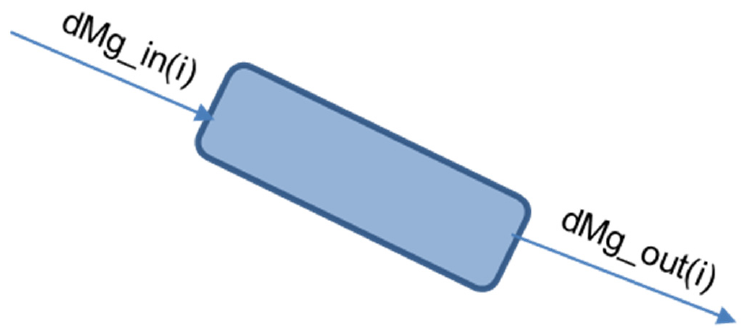
Figure 8. Schematic of air segment mass changes.